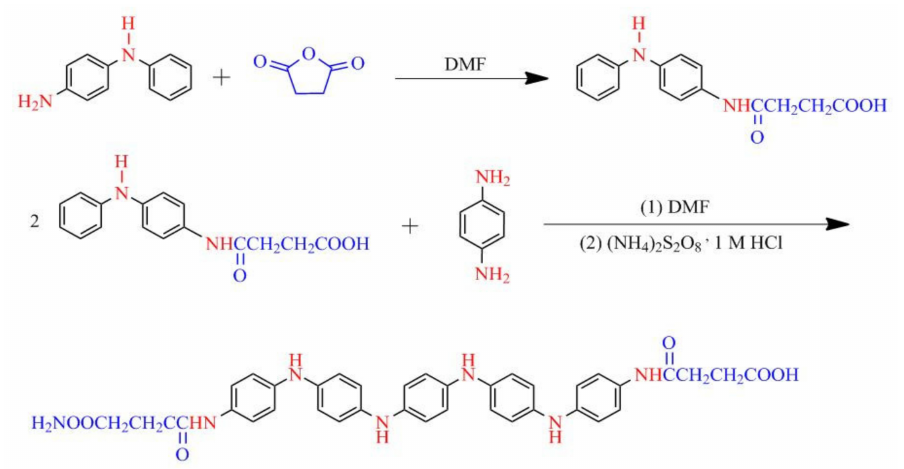
Figure 14. The synthesis pathway of carboxyl-capped aniline